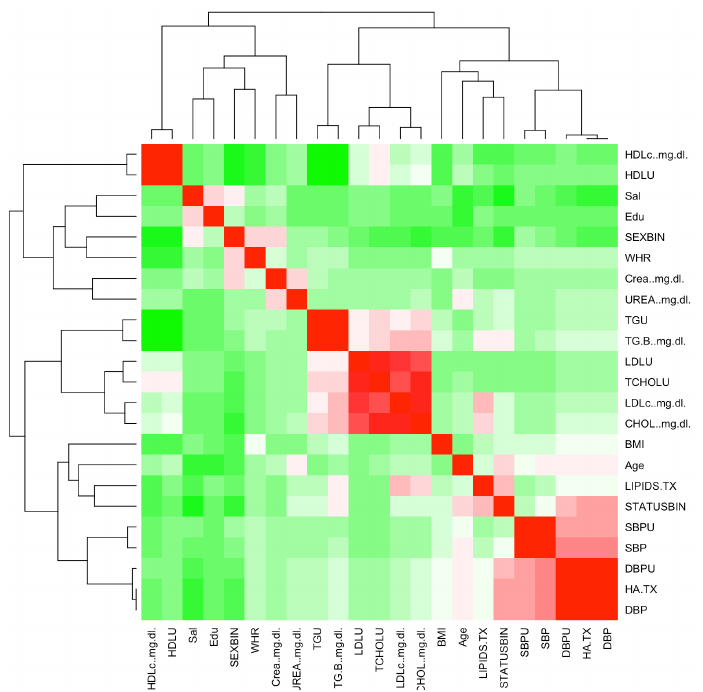
Figure 2. Feature Correlation Heat